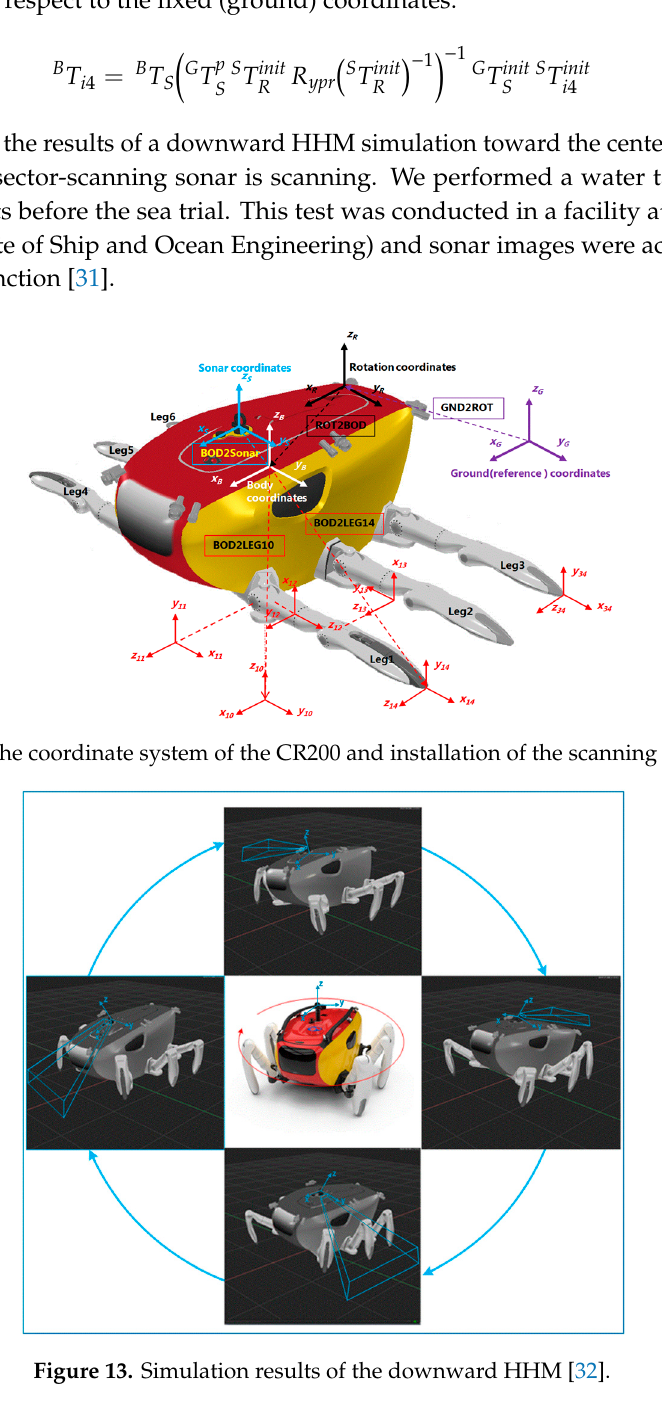
Figure 14. CR200 system on the barge.